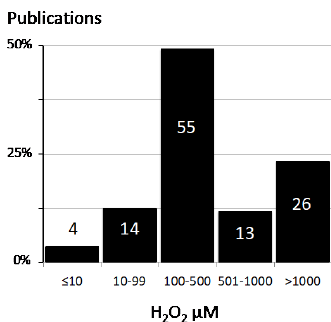
Figure A2. The histogram shows the percentage ( Y axis) and the number of publications according to H 2 O 2 concentrations. Table A1. The list hereafter indicates the PMID identifiers of the articles considered.